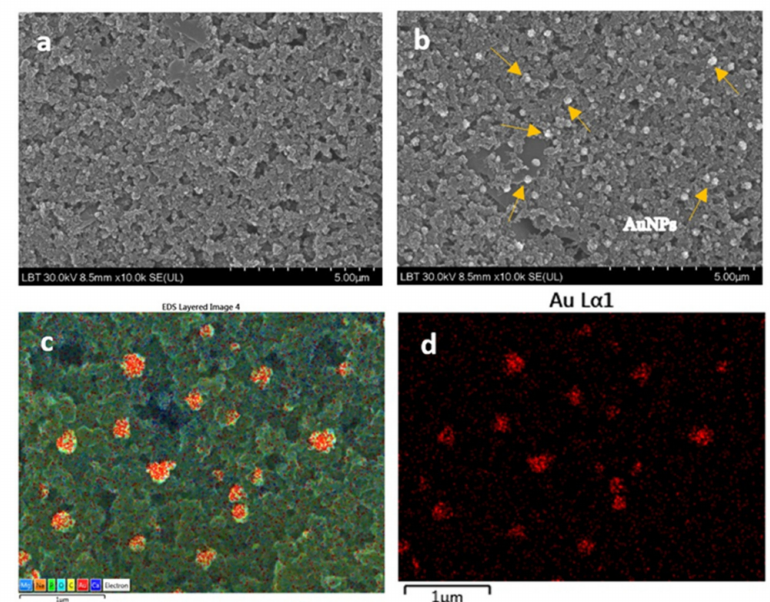
Figure 2. Scanning electron microscope (SEM) image of bare flexible screen-printed electrode (HP) ( a ) and gold nanoparticles (AuNPs)-modified electrode (HP-AuNPs) ( b ); scale bar: 5 µ m. Energy-dispersive X-ray spectroscopy (EDS) images of HP-AuNPs electrode surface, confirming the presence of gold nanoparticles ( c , d ); scale bar: 1 µ